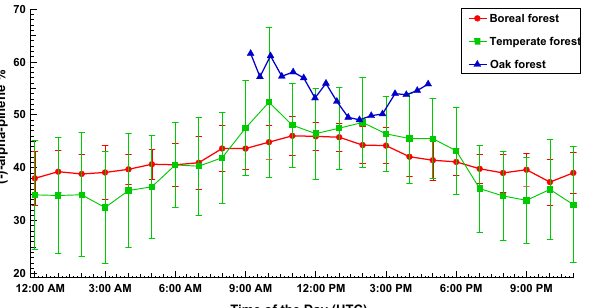
Fig. 9. Enantiomeric fraction of ( − )- α -pinene over the Quercus ilex forest, boreal forest and temperate